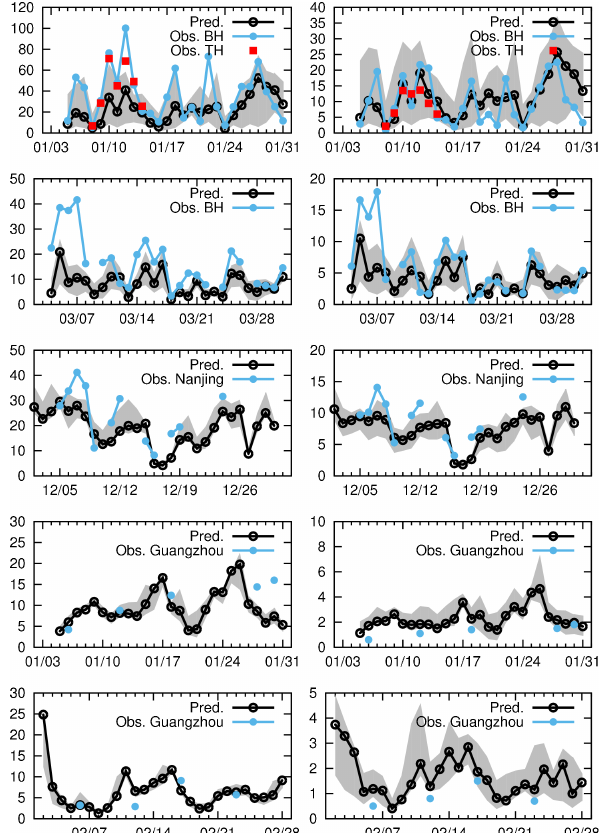
Figure 3. Predicted and observed concentrations of total organic carbon (OC, left column) and elemental carbon (EC, right column) in several different cities. BH: Beihang University campus; TH: Ts- inghua University campus; Nanjing: Jiangsu Provincial Academy of Environmental Science; Guangzhou: Tianhu (rural site). Shaded areas represent the range of predictions in the nine grid cells with the monitor site at the center. Units are µgm − 3